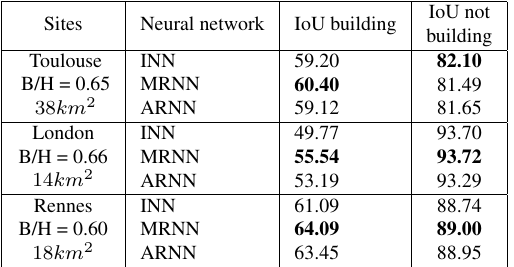
Table 3. Mean IoU obtained with and without annotations.